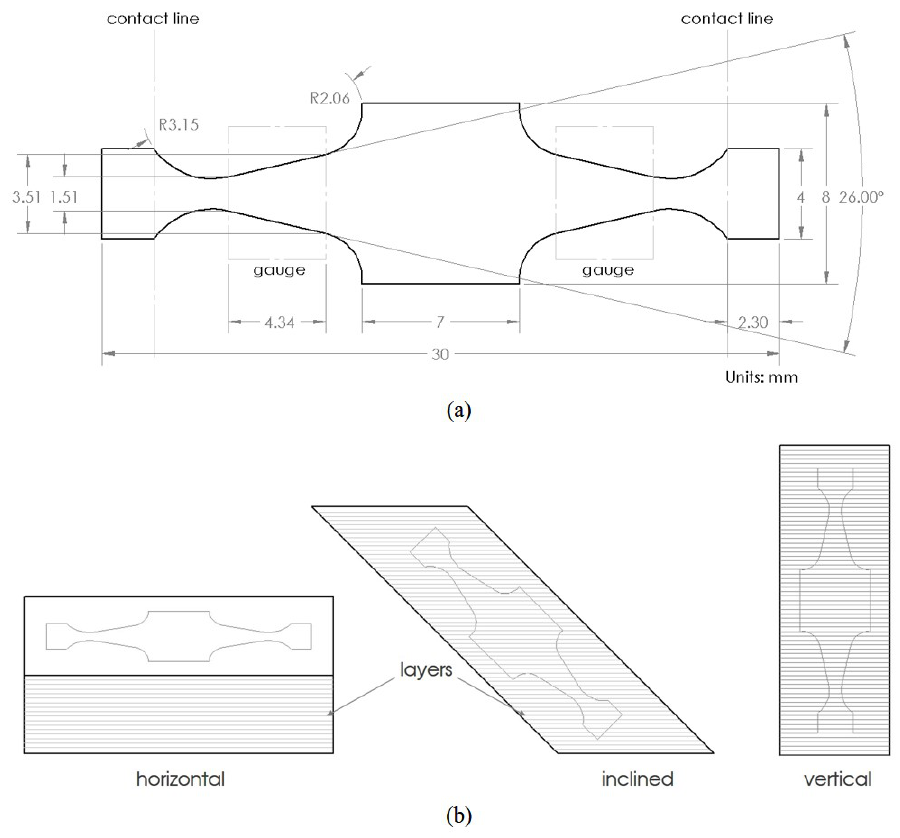
Figure 6. Schematic representation of ( a ): the miniature specimen including the dimensions with the dual gauge section and line contact, ( b ): the specimen cut at horizontal, inclined, and vertical orientation